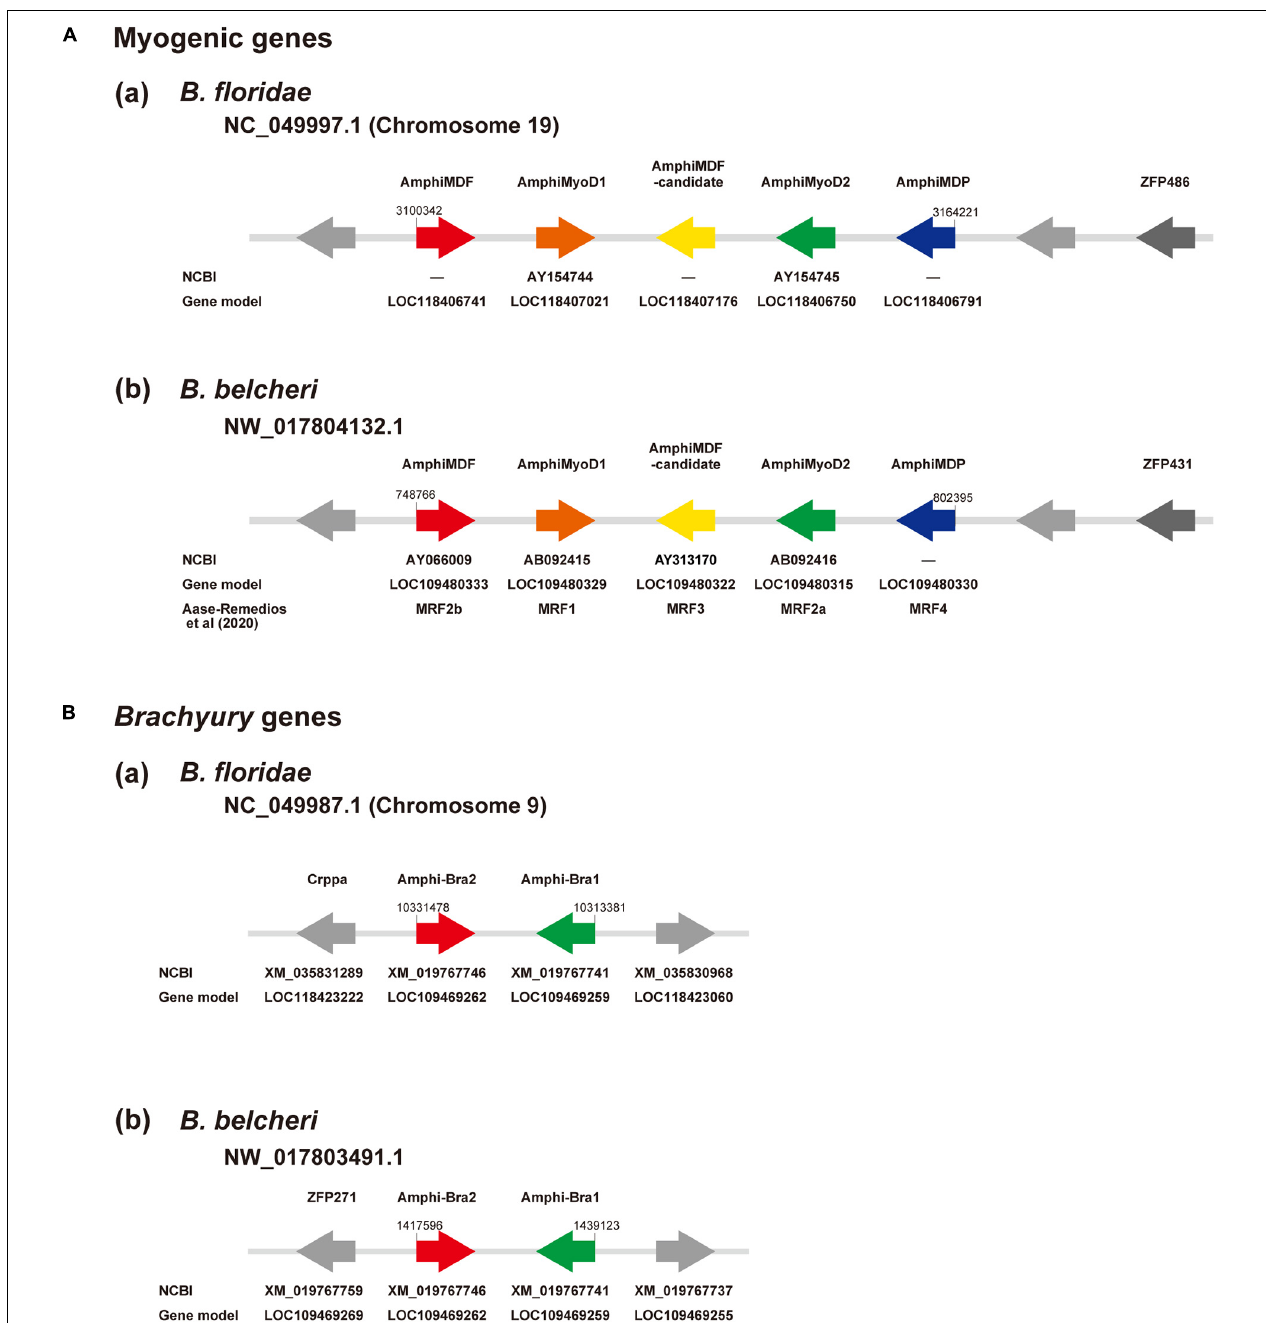
FIGURE 3 | (A) Myogenic factor genes and (B) Brachyury genes in amphioxus genomes. (A) Genomic region containing a cluster of myogenic factor genes in (a) Branchiostoma floridae and (b) B. belcheri . In scaffold NC_049997.1 of chromosome 19 in B. floridae and NW_017804132.1 in B. belcheri , there is a cluster that contains five genes for myogenic factors, from left to right, MDF (red), MyoD1 (brown), a candidate myogenic factor gene (yellow), MyoD2 (green), and myoblast determination protein (blue). Two undefined genes are shown in gray and a zinc finger protein gene is shown in dark gray. Arrows indicate the direction of transcription. (B) Genomic region containing two Brachyury genes, Bra2 (red) and Bra1 (green), in (a) Branchiostoma floridae scaffold NC_049987.1 of chromosome 9 and (b) B. belcheri scaffold NW_017803491. Arrows indicate the direction of